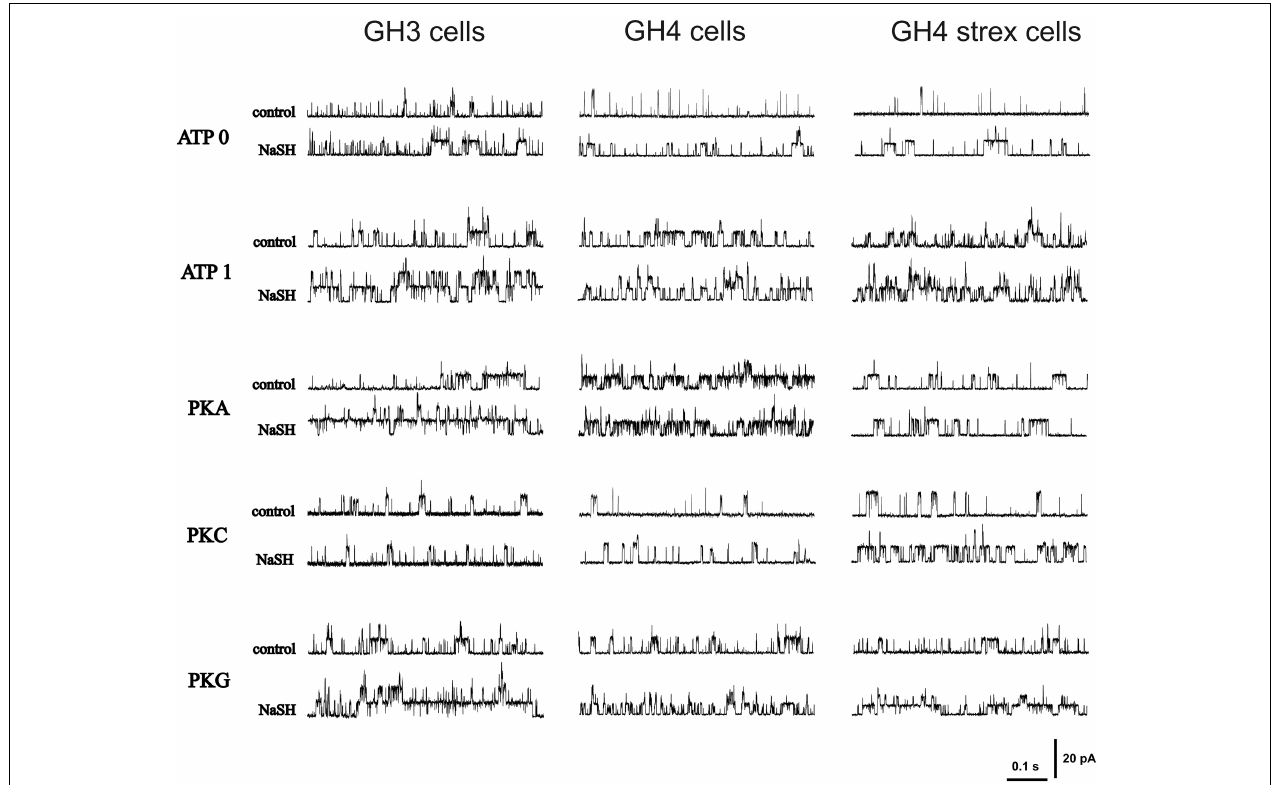
STREX) during various phosphorylation conditions (control) and after NaHS (300 μ M NaHS, equivalent to effective 34–41 μ M H 2 S) application. Holding potential + 30mV.